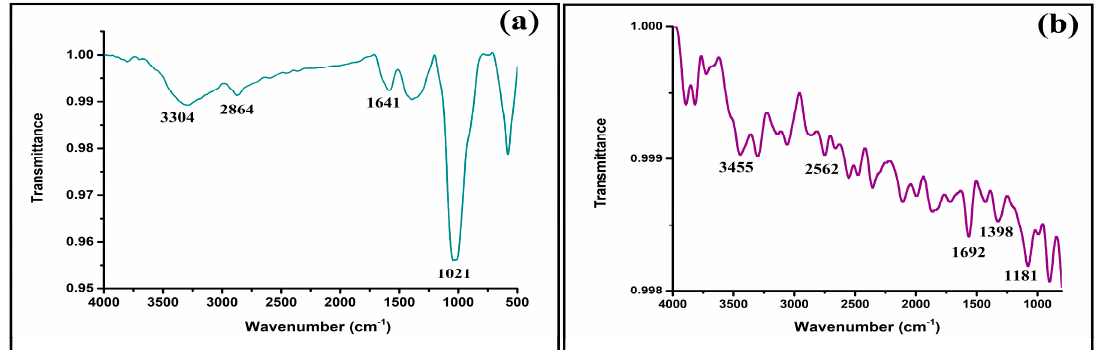
Figure 1. FTIR spectra of ( a ) chitosan and ( b ) CCA.